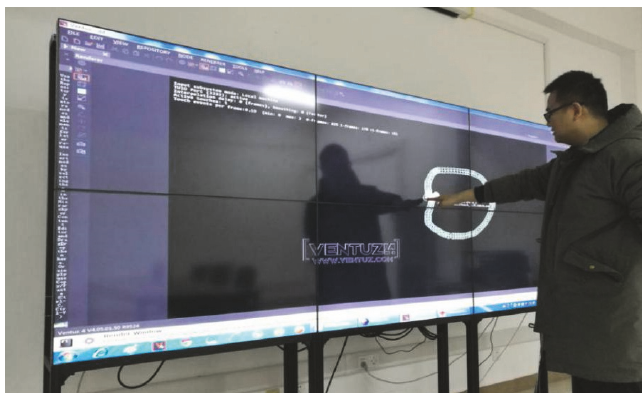
Figure 5: The one-hand gesture tracking effect based on switching federated filter algorithm.